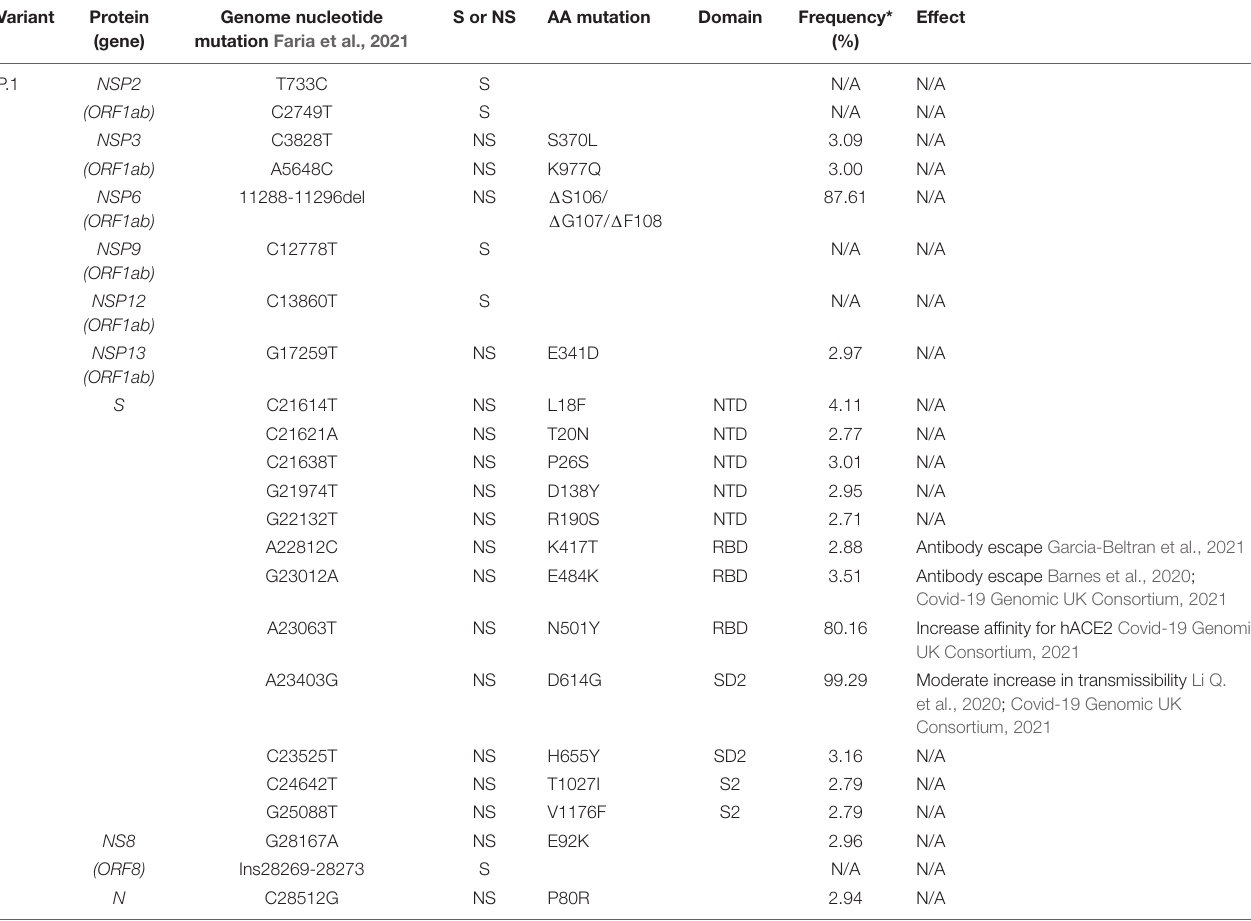
TABLE 4 | Synonymous, non-synonymous, and deletions in the P.1 (Brazil) variant.